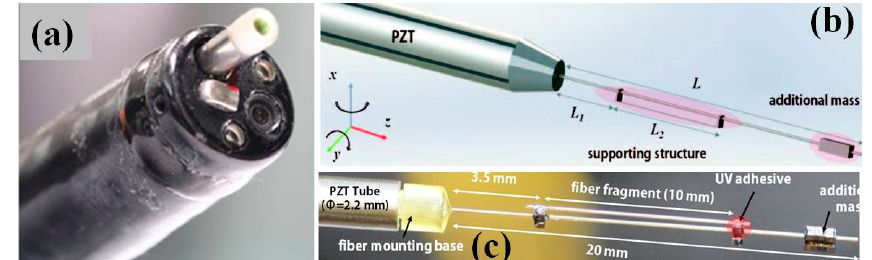
Figure 7. Endomicroscopic OCT system based on micromachined tethered silicon oscillator. ( a ) Fully packaged OCT endomicroscope inside a gastrointestinal endoscope, the endomicroscope with compact packaging passes through the accessory channel. ( b ) Schematic illustration of a Lissajous fiber scanner mounted inside a quardrapole piezoelectic tube with micromachined silicon structure. ( c ) Photograph of the fully micro-assembled Lissajous fiber scanner. A 20 mm long fiber cantilever with additional supporting structures was mounted on a PZT tube (Reproduced with permission from OSA [57]).